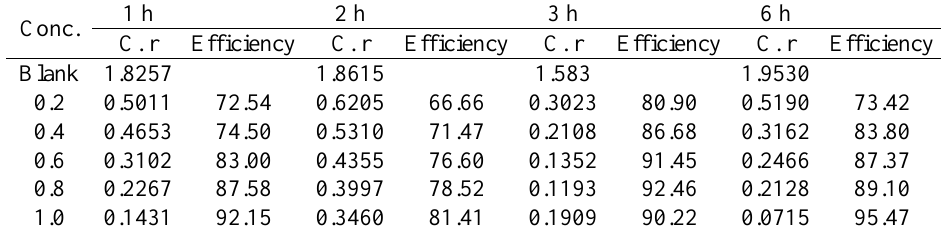
Table 4. Inhibitor efficiency and corrosion rate in HNO copper metal in 3 N HNO using Azadirachta indica seed 3